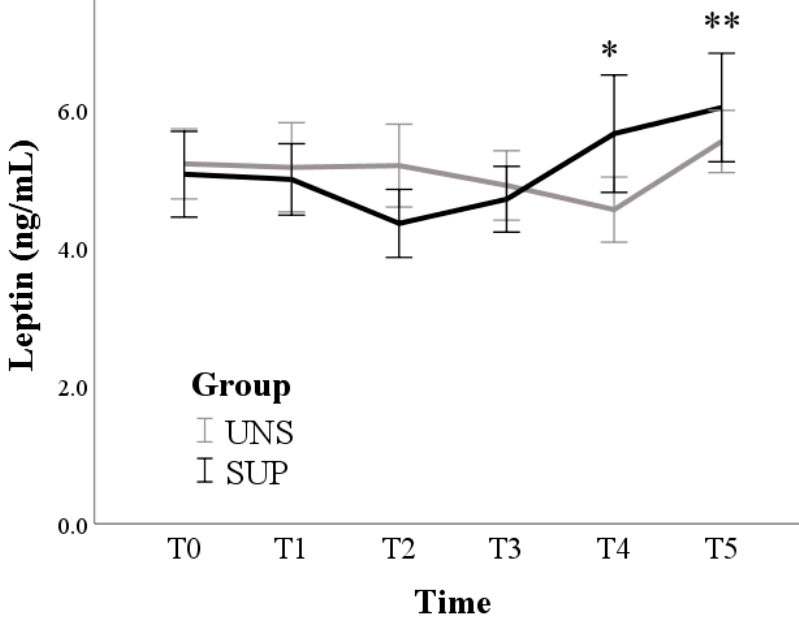
Figure 5. Means and standard errors of leptin plasma concentrations in control (UNS) and supple- mented (SUP) lactating sheep monitored before the administration of supplementation (T0), and then every 10 days until dry off (T1–T5). * p < 0.05, ** p < 0.01: each time vs. T0 in SUP. TH concentrations reduced after 10 days (from 3.2 ± 0.1 nmol/L at T0 to 2.8 ± 0.1 at T1; p < 0.001) but subsequently stabilized without differences between groups ( p = 0.491) (Figure 6).